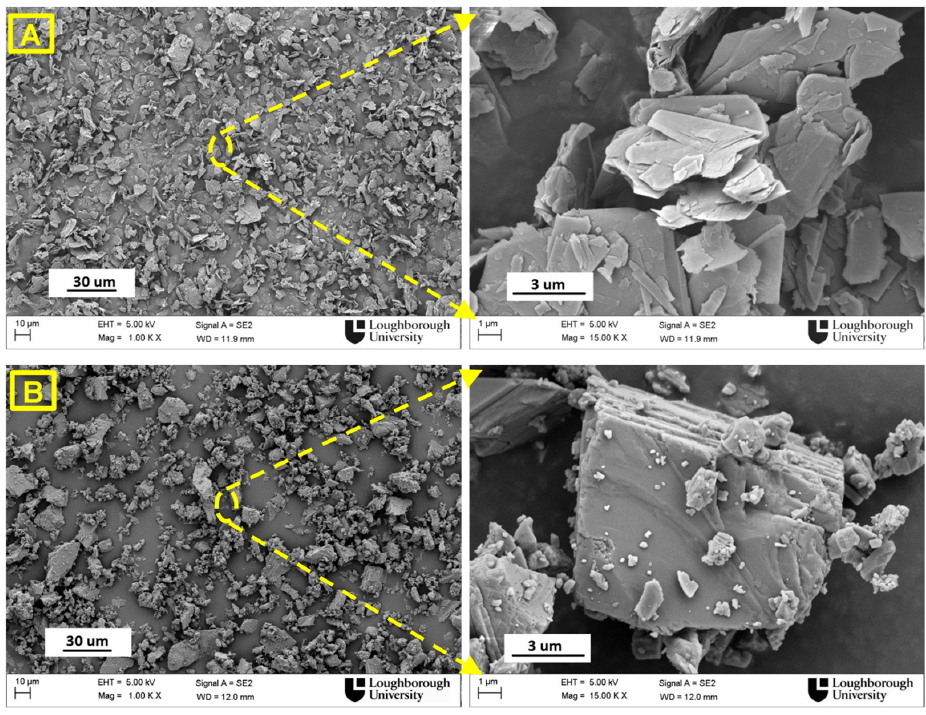
Figure 1. Scanning electron microscope (SEM) images of ( A ) talc and ( B ) calcium carbonate.